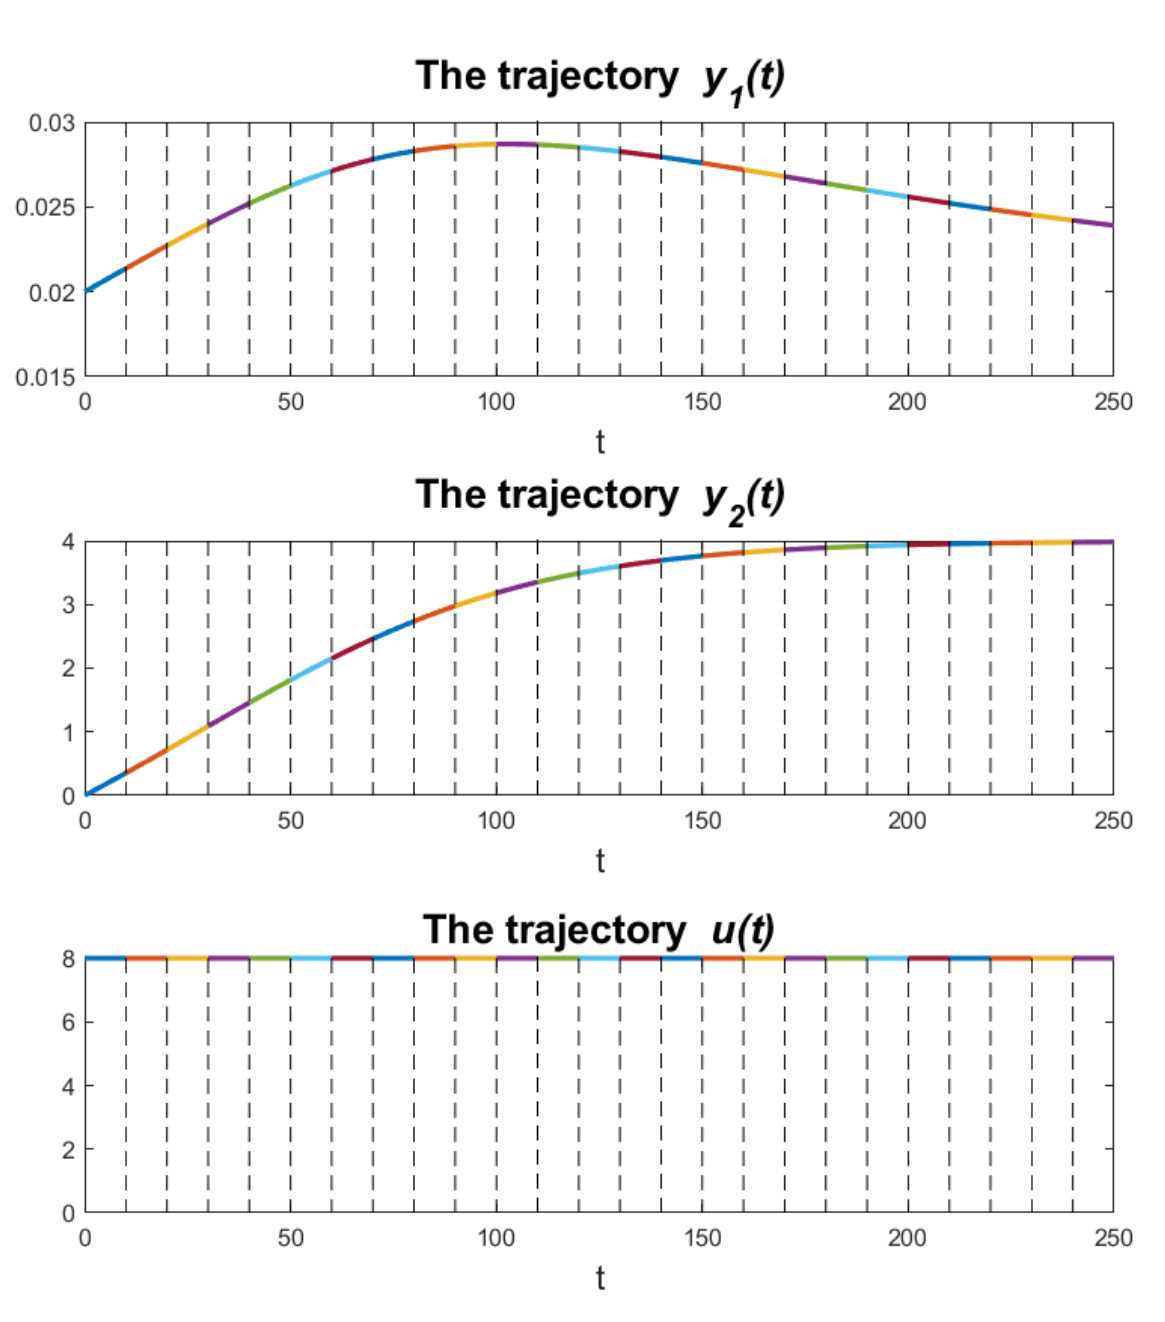
Figure 3. The obtained solution trajectories for u ( t ) =